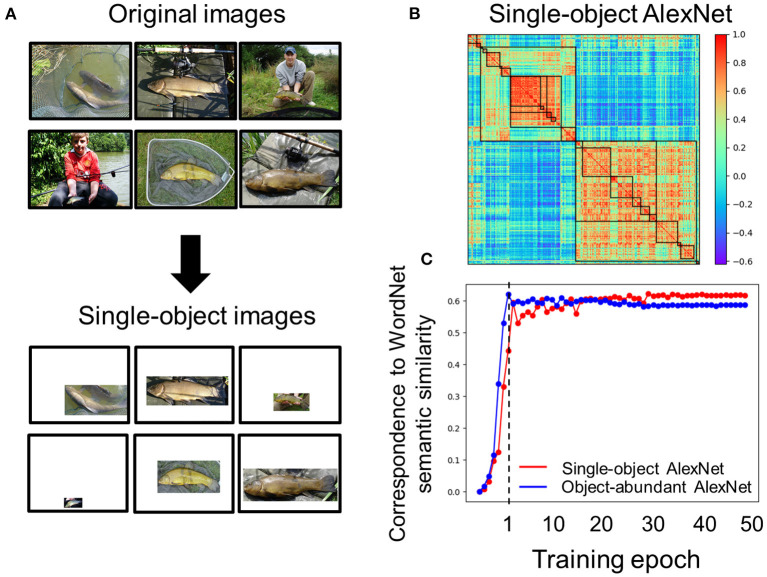
Effect of object co-occurrence on the emergence of semantic relatedness in AlexNet. (A) Original images used for training AlexNet contain objects present in the background, which may contribute to the emergence of semantic relatedness in AlexNet. After removing the background, only one object remained. (B) Category similarity of the single-object AlexNet, which was trained with images containing only one object. Hierarchical relation is prominent. (C) The developmental trajectory of the single-object AlexNet (red) was drawn against that of the original AlexNet (blue). Note that to match the number of images used to train the single-object AlexNet, stages for training the original AlexNet with 600,000 to 1,200,000 images within the first epoch were not plotted.